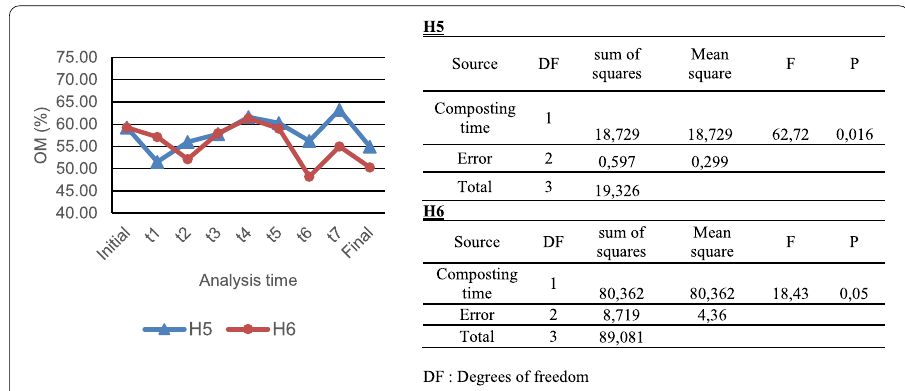
Fig. 6 OM evolution during co‑composting of TM and OP (left) and ANOVA test associated